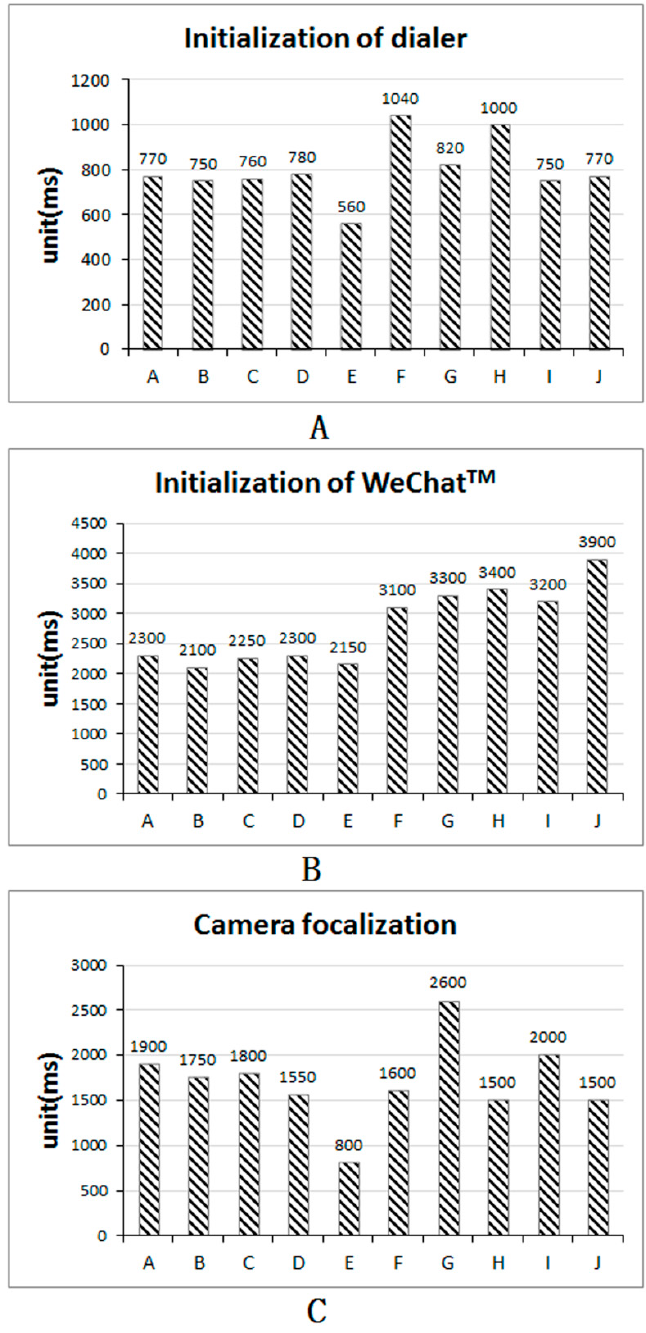
Figure 2. Measured loading time for three scenarios from 10 mobile phones. To protect commercial interests, the types of the products were labeled by A to J. ( A ) Initialization of dialer. ( B ) Initialization of WeChat TM . ( C ) Camera